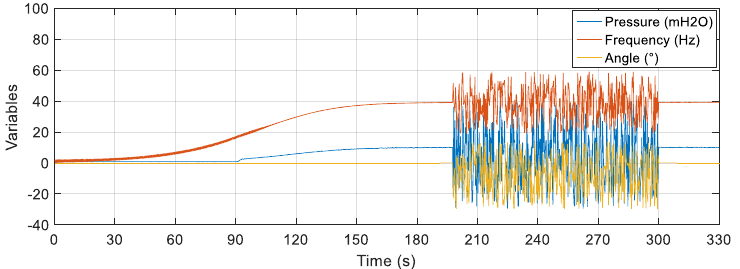
Figure 21. Rotation frequency, CV-1 valve angle and PT-3 pressure input signals with noise.